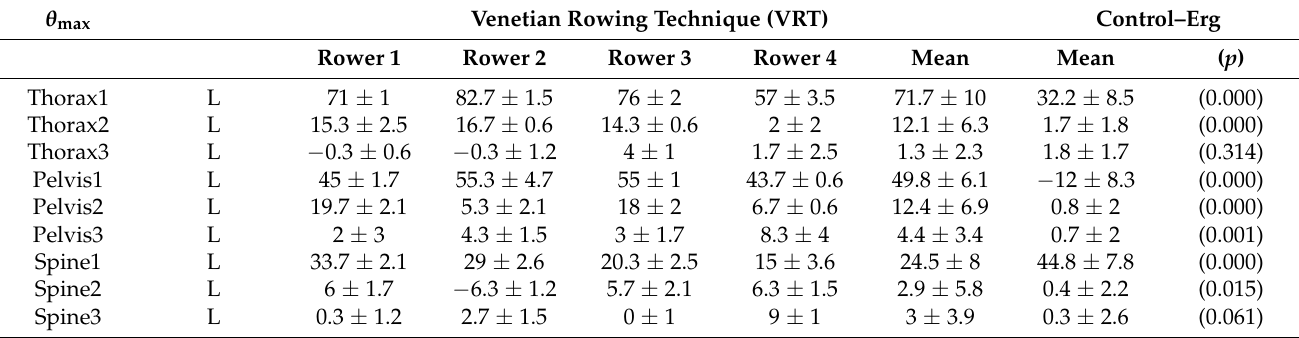
Figure 6. Angle–Angle plots, which illustrate the relationship between movements in sagittal plane of the pelvis/spine with that of the thorax. See also Supplementary Materials. Table 3. The maximum values, θ max , of the thorax, pelvis and spine angles measured for the Venetian style rowing technique, in degrees, ± 1 s.d., compared to its equivalent mean value for standard ergometer